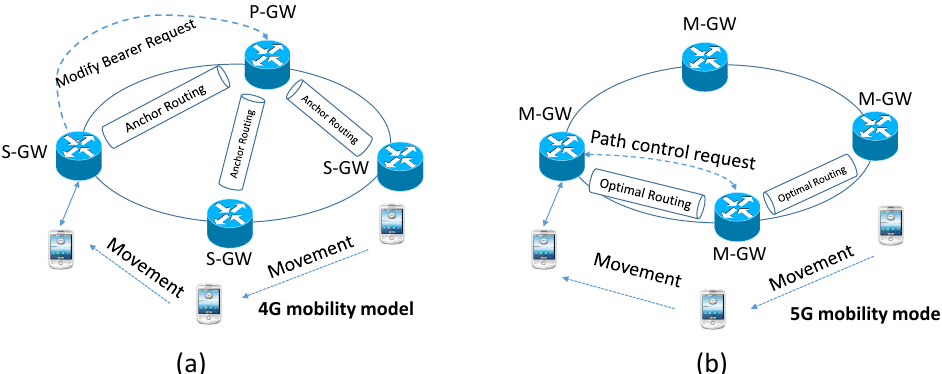
Figure 7. The mobility with gateway relocation in ( a ) 4G and ( b ) proposed 5G concept.